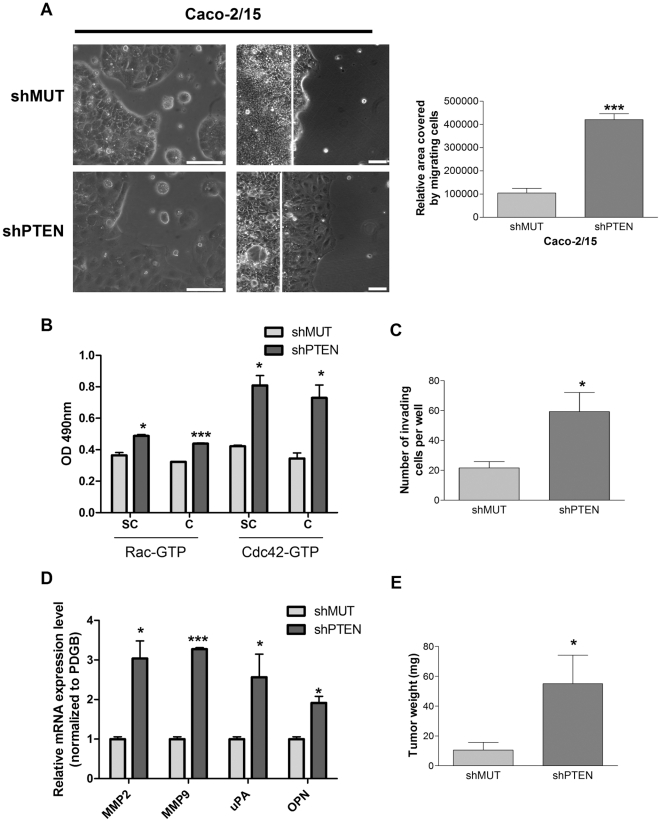
PTEN down-regulation in Caco-2/15 increases migration/invasion capacity and tumorigenic potential.
A. Left panels: Cell morphology was analyzed by phase contrast microscopy at subconfluence. Right panels: Newly confluent cells stably expressing shMUT or shPTEN were wounded and treated with 2 mM hydroxyurea. After 48 h, movement of the coherent sheet across the linear wound margin (white line) was evaluated by phase contrast microscopy. The graph on the right illustrates the relative area covered by migrating cells as assessed on 5 different wound experiments per condition using Image J software. Scale bars  = 100 µm. B. Activated levels of GTP-bound Rac or Cdc42 were analyzed with G-LISA activation assay biochemistry kits on subconfluent (SC) and newly confluent (C) Caco-2/15 cells. C. Invasion of cells was studied using Matrigel-coated Transwells. After 48 h, invading cells were fixed, stained with crystal violet 1% and counted. D. Subconfluent shMUT and shPTEN-expressing Caco-2/15 cells were lysed and total RNA isolated for gene expression analyzed by Q-PCRs. The relative level of each RNA was calculated using the standard curve method and normalized to the corresponding PDGB RNA level. E. 2×106 proliferating Caco-2/15 cells expressing shMUT or shPTEN were injected subcutaneously in 5 nude mice per condition. Tumor weight was evaluated 42 days after injection. * p≤0.05, *** p≤0.005, statistical differences determined using Student's t-test.